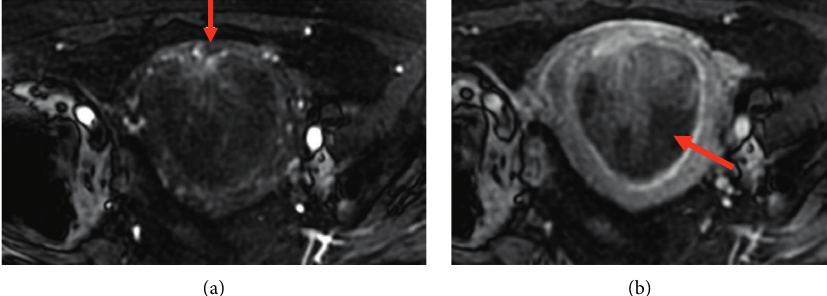
Figure 5: Pelvic MRI of endometrial stromal sarcoma: (a, b) axial DCE-MRI showing tumoral vessels in the lesion at arterial phase and disruption of arcuate arteries subendometrial ring (arrow) (a) and percentage of necrosis at venous phase (arrow) (b).